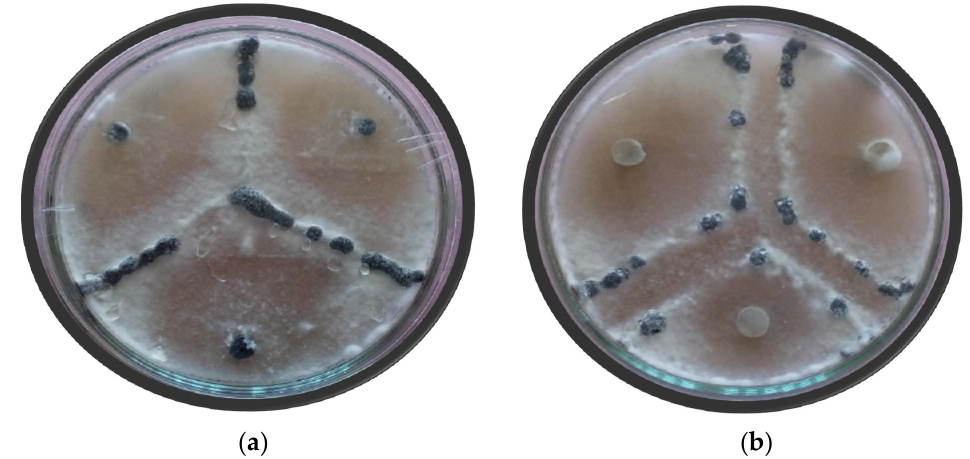
Figure 2. Compatible and incompatible reaction among different isolates of S. sclerotiorum from common beans in Kashmir: ( a ) Sclerotia produced at the ridge by compatible isolates; ( b ) clear barrage zone between the incompatible isolates. Table 3. Mycelial compatibility groups of S. Sclerotiorum pathogen on beans in Kashmir, constituent isolates, and area of occurrence.